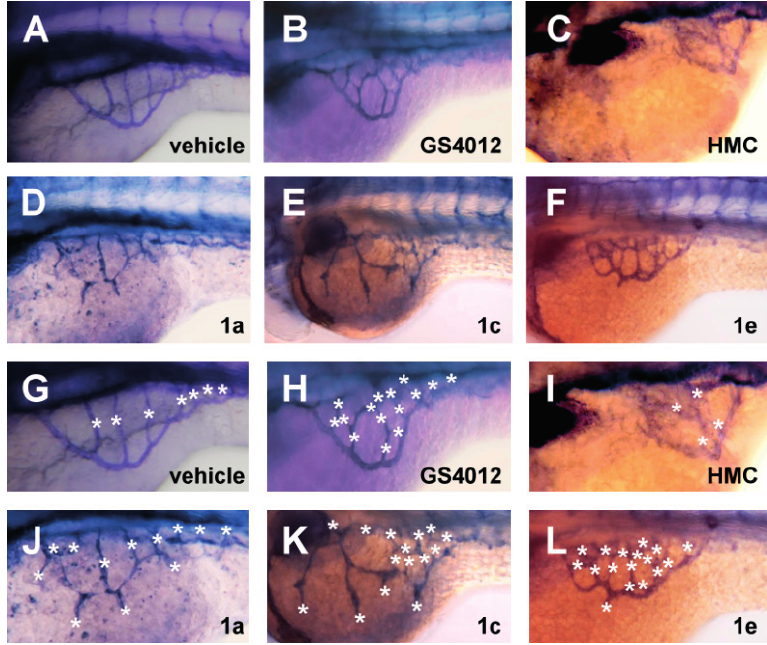
Figure 5. Chalcone derivatives caused pro-angiogenic effect on the wild type